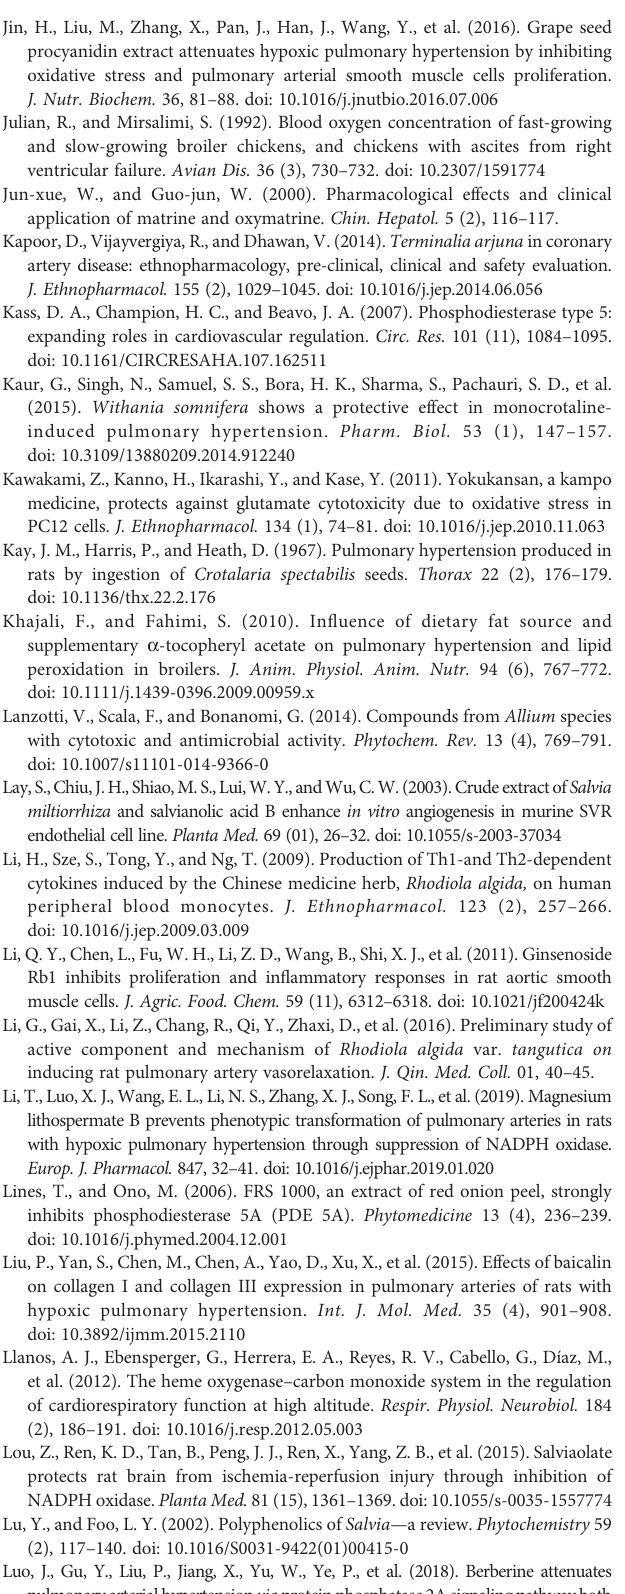
fl avones through registration of intracardiac potentials in anesthetized